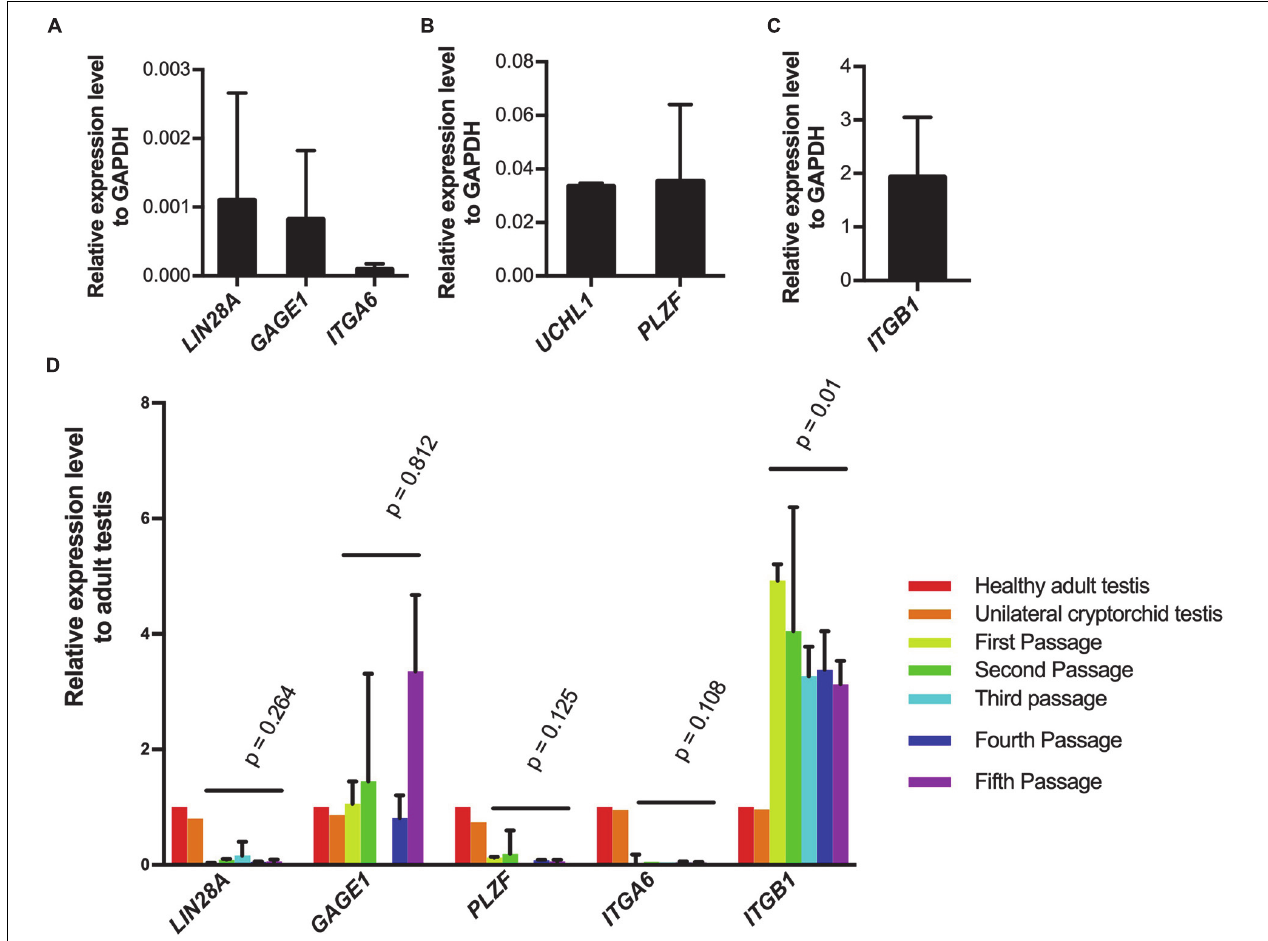
FIGURE 5 | Germ cell marker expression analysis of SSCLCs. A-C , qPCR analysis showing the expression of germ cell markers LIN28A, UCHL1, GAGE1, ITGA6, ITGB1 relative expression level to GAPDH in primary SSCLCs. The bars show standard deviations. (D) , The relative expression levels of LIN28, GAGE, PLZF, ITGA6 and ITGB1 to adult testis and error bars in the SSCLCs of passage 1–5. P -values are showing the statistics analysis using one-way